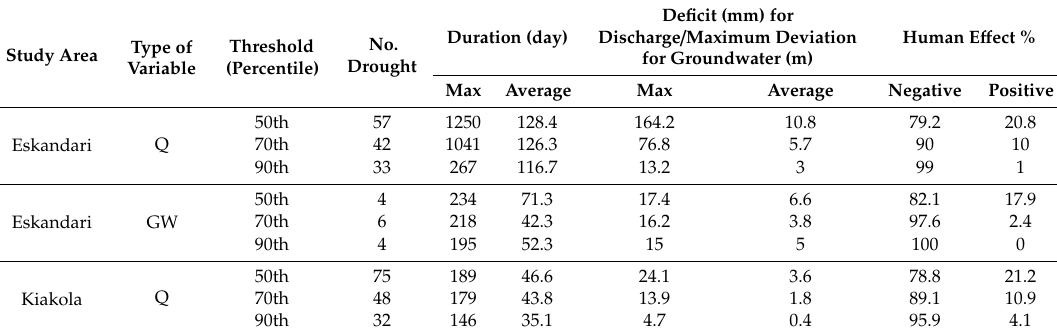
Table 7. Human-modified drought